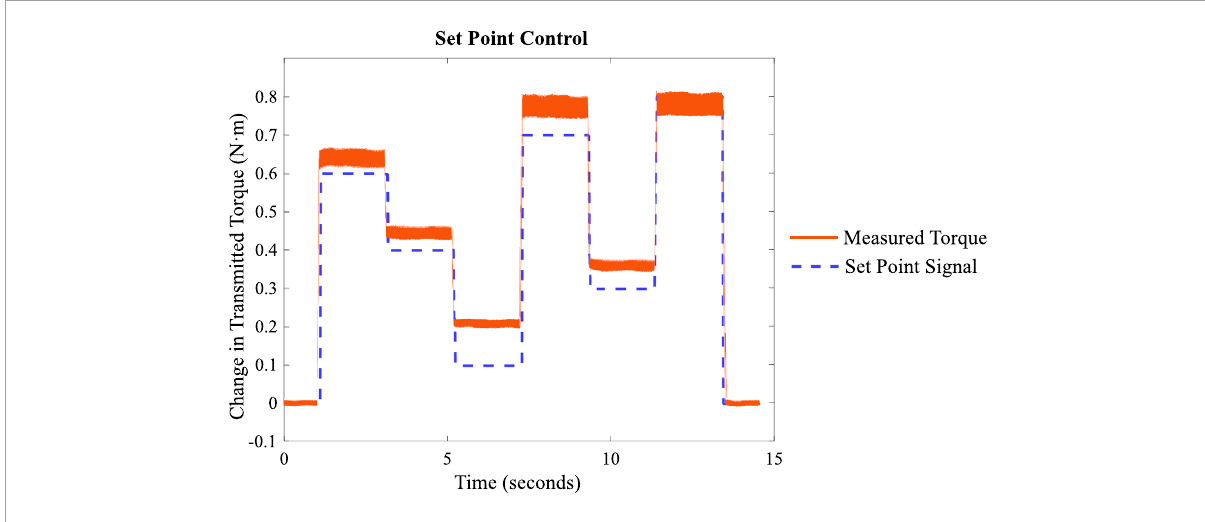
FIGURE 12 Demonstrating the set-point control strategy using the equations derived from the data in Figure 11 .